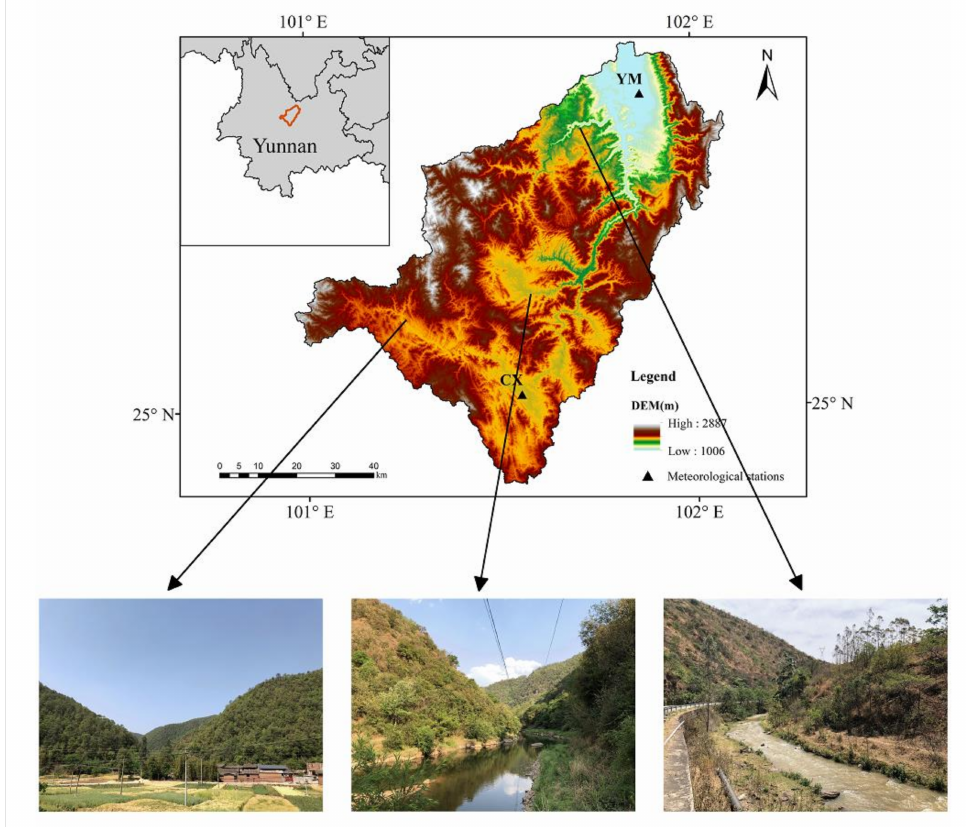
Figure 1. Location of study area with meteorological stations and vegetation